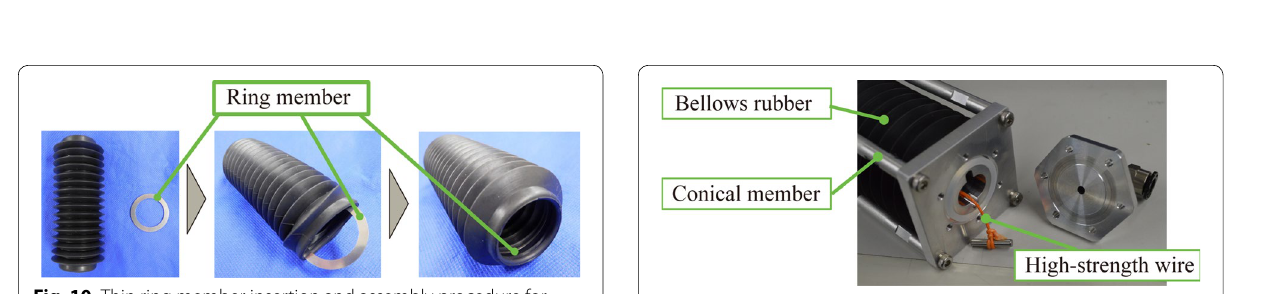
Fig. 11 Method for improving load-bearing capacity of the bellows pneumatic